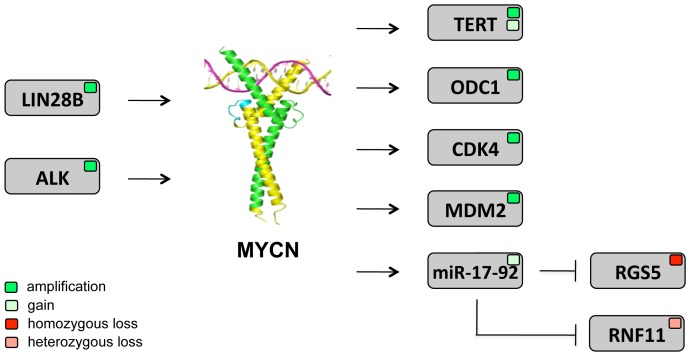
Rare recurrent focal copy number changes in neuroblastoma target up and downstream MYCN pathway components.Illustration of genes in focal genomic gains (light green) and amplifications (dark green) that are direct up regulated MYCN target genes or upstream regulators of MYCN and genes in focal heterozygous (light red) and homozygous (dark red) deletions which are down regulated by MYCN through its activated miRNAs. Protein structure was obtained from www.pdbe.org.